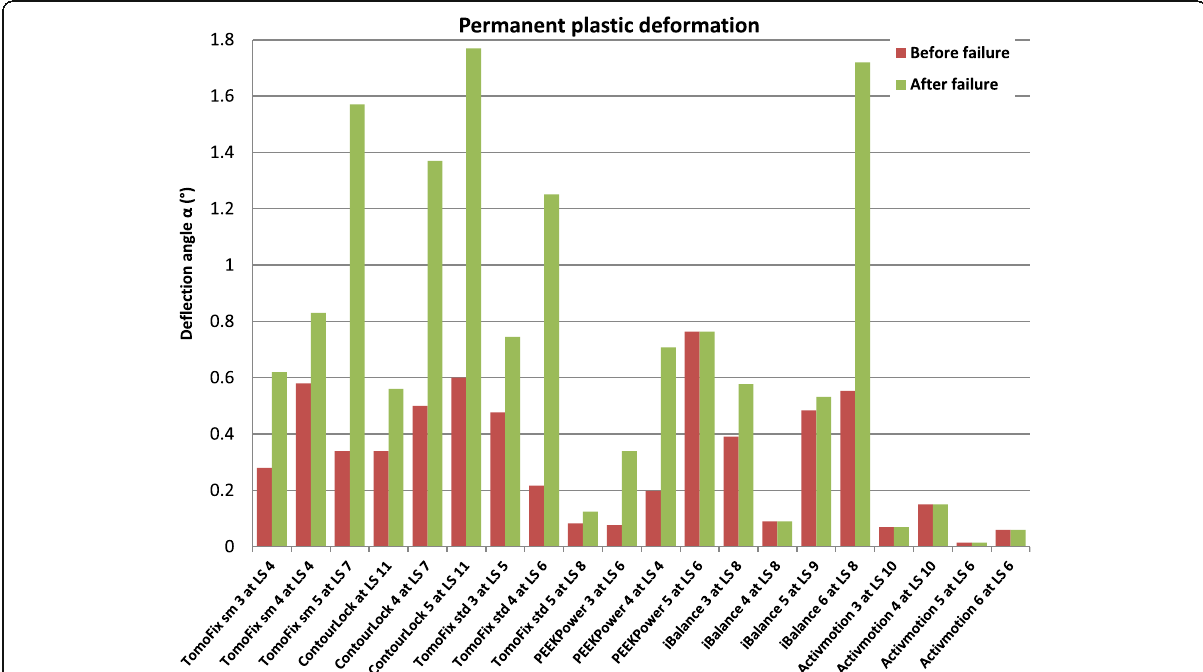
Fig. 8 Comparison of the deflection angle or valgus-malrotation of the tibial head before and after the failure for groups 1, 2, 3 and 6: The failure type 1 was observed in the case of the specimen iBalance 6 after the collapse of the opposite cortex. LS “ n ” means the failure occurred at load step “ n ” . The values of the first 3 groups are retrieved from our previous